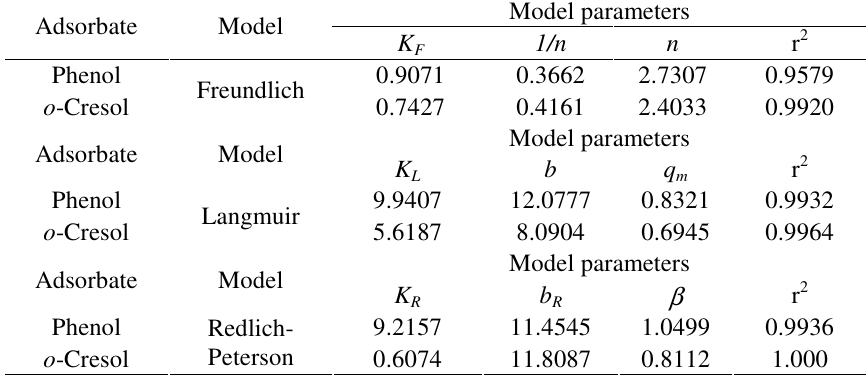
Table 6. Isotherm parameters for adsorption of phenols on CC at 45 ° C